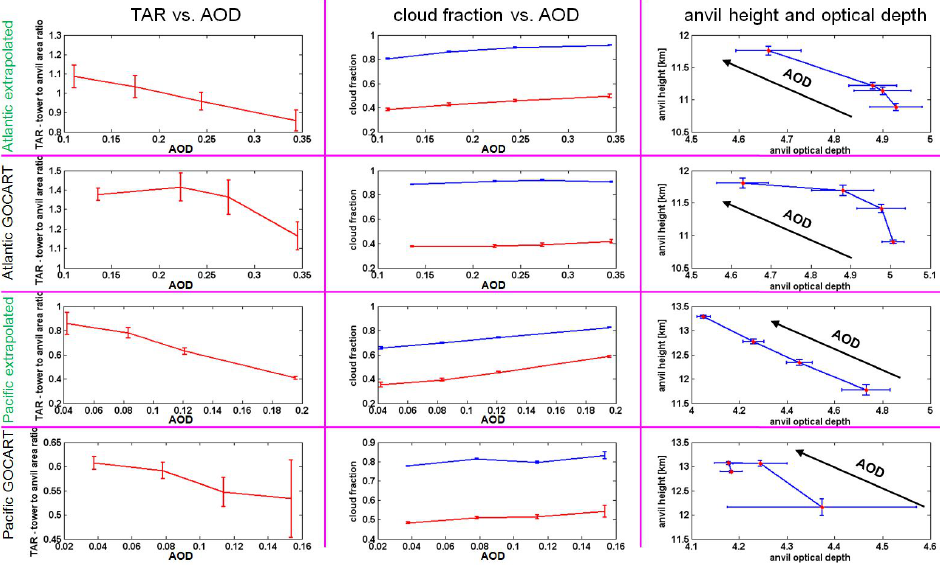
Fig. 6. Same as Fig. 3 except for using two alternative methods to determine aerosol loading. The first and third rows use the MODIS AOD data but extrapolate from retrieved grid boxes into fully overcast grid boxes that did not contribute to the statistics of Fig. 3. The first and second rows show results of the Atlantic set and the third and forth show results of the Pacific. This method allows inclusion of the tallest, most invigorated convective systems. The second and fourth rows use the GOCART chemical transport model (Chin et al., 2000) to provide the aerosol information that is collocated with the satellite-retrieved cloud variables. The trends exhibited by these two alternative methods are the same as shown in Fig. 3, demonstrating the robustness of the phenomena